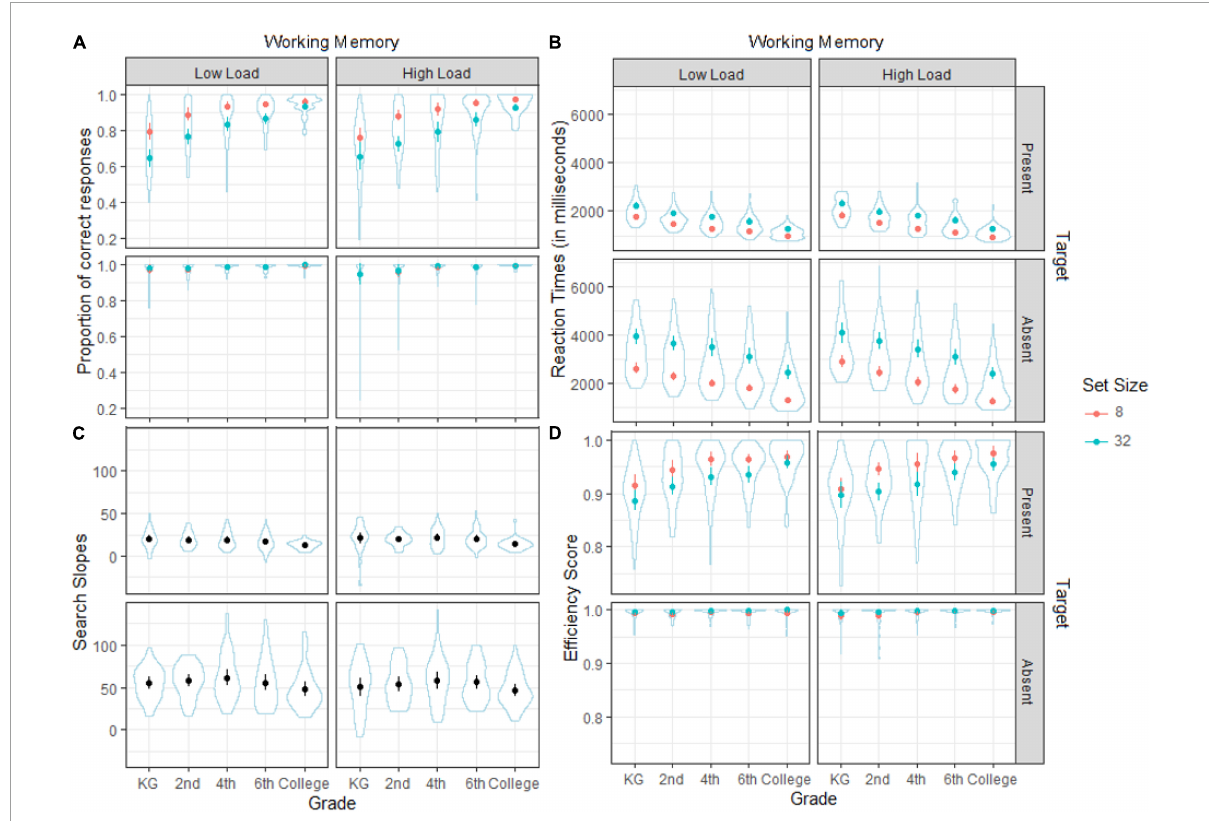
FIGURE4 Mean proportion of (A) correct responses, (B) reaction time, (C) search slopes, and (D) efficiency score as a function of grade, set size, working memory load, and target. Mean of search slopes as a function of grade, working memory load, and target. Bars represent the confidence intervals for each mean represented by